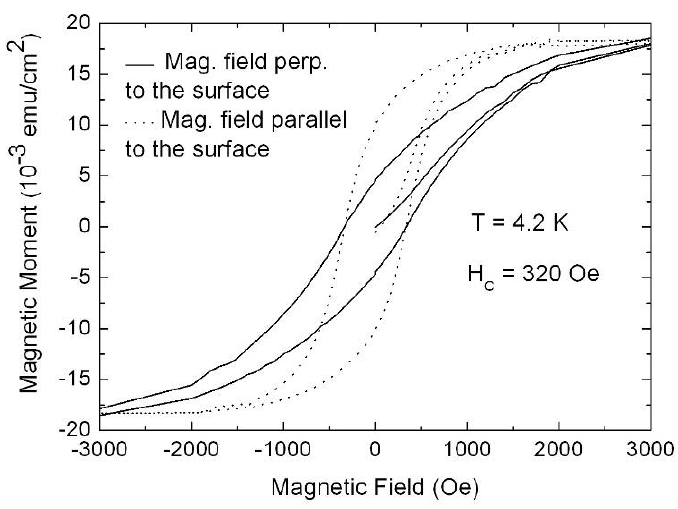
Figure 42. Magnetization measurements of a magnetite solution covered silicon wafer performed with the magnetic field applied perpendicular to the surface (full line) and parallel to the surface (dotted line), respectively. The obtained anisotropy is alike to the one O -particles which form a thin layer interact of a magnetic film affirming that the Fe 3 4 dipolarly (reproduced by permission of The Electrochemical Society